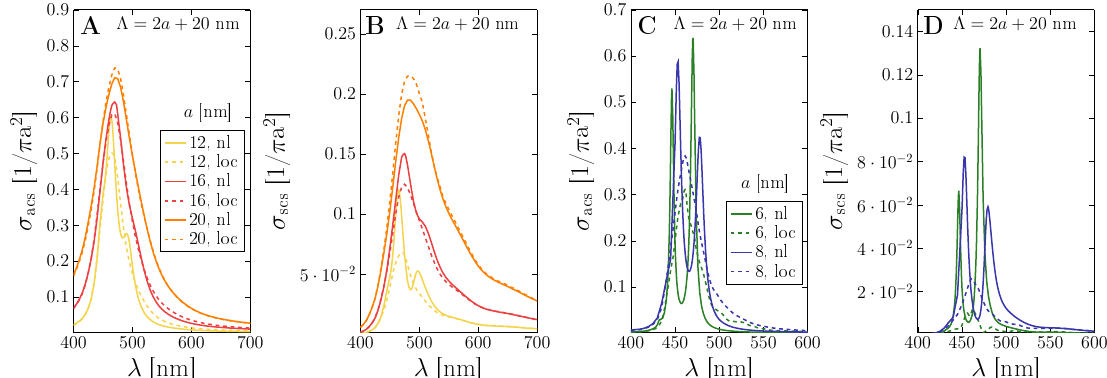
Figure 5. Impact of nonlocality on the strongly coupled system. A gold nanoparticle array with lattice period Λ = 2 a + 20 nm is placed on a Si substrate. Normalized ( A ) absorption ( σ acs ) and ( B ) scattering cross section ( σ scs ) for particle sizes above 10 nm comparing classical and nonlocal theory. ( C ) Absorption and ( D ) scattering cross section for particle sizes below 10 nm comparing classical and nonlocal theory. In this regime, strong coupling leads to the Autler–Townes splitting of the local mode in the semi-classical picture.